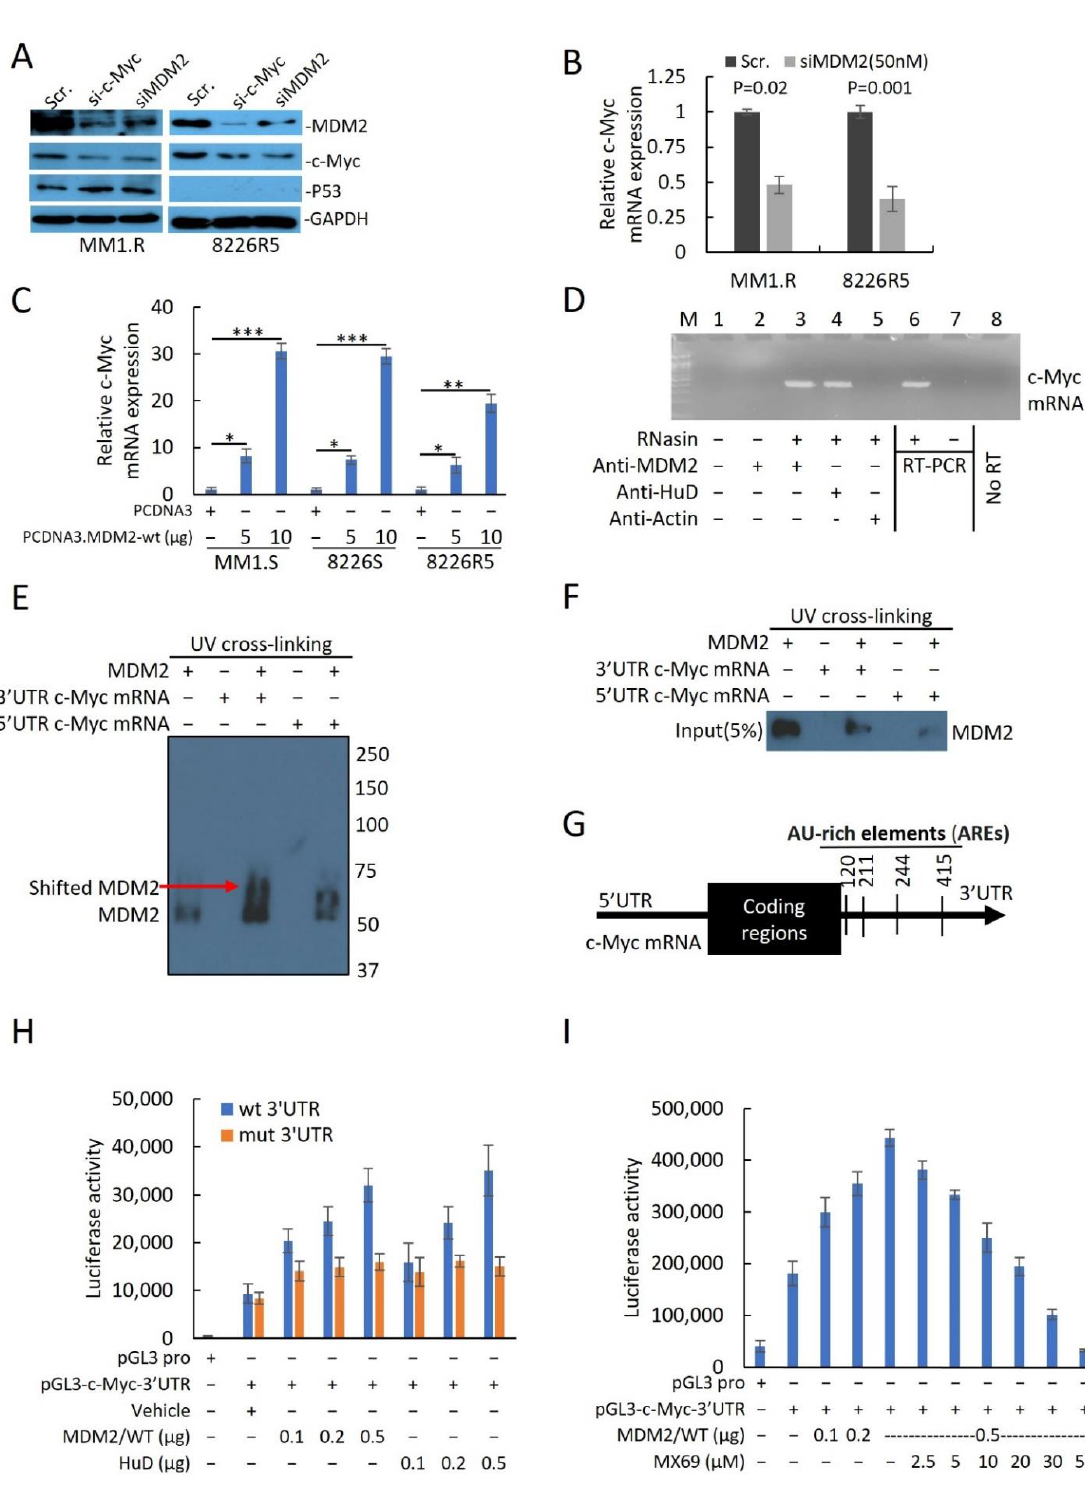
mean ± SD of three independent experiments. ( E ) Cell viability of normal donor PBMCs after 48 h treatment with DMSO or single/combination treatment with 30 µ M MX69 and 20 nM BTZ, as indicated. Results are presented as mean ± SD of three independent experiments. *, p < 0.05;